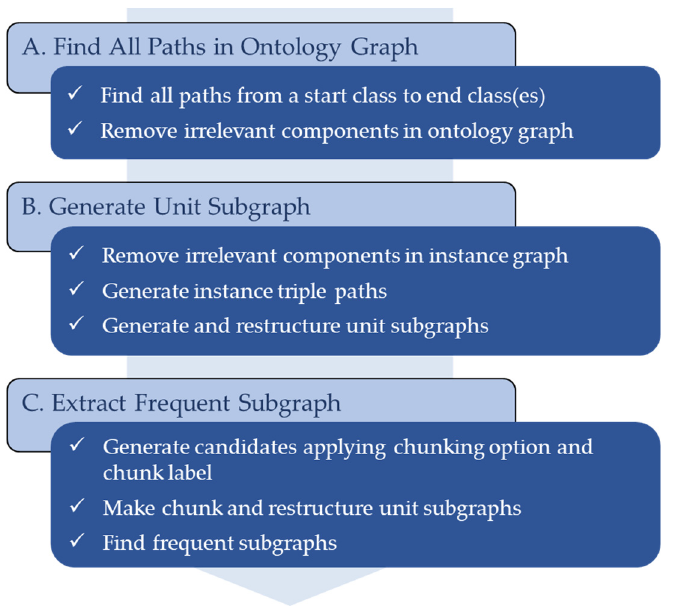
Figure 1. Proposed methodology.